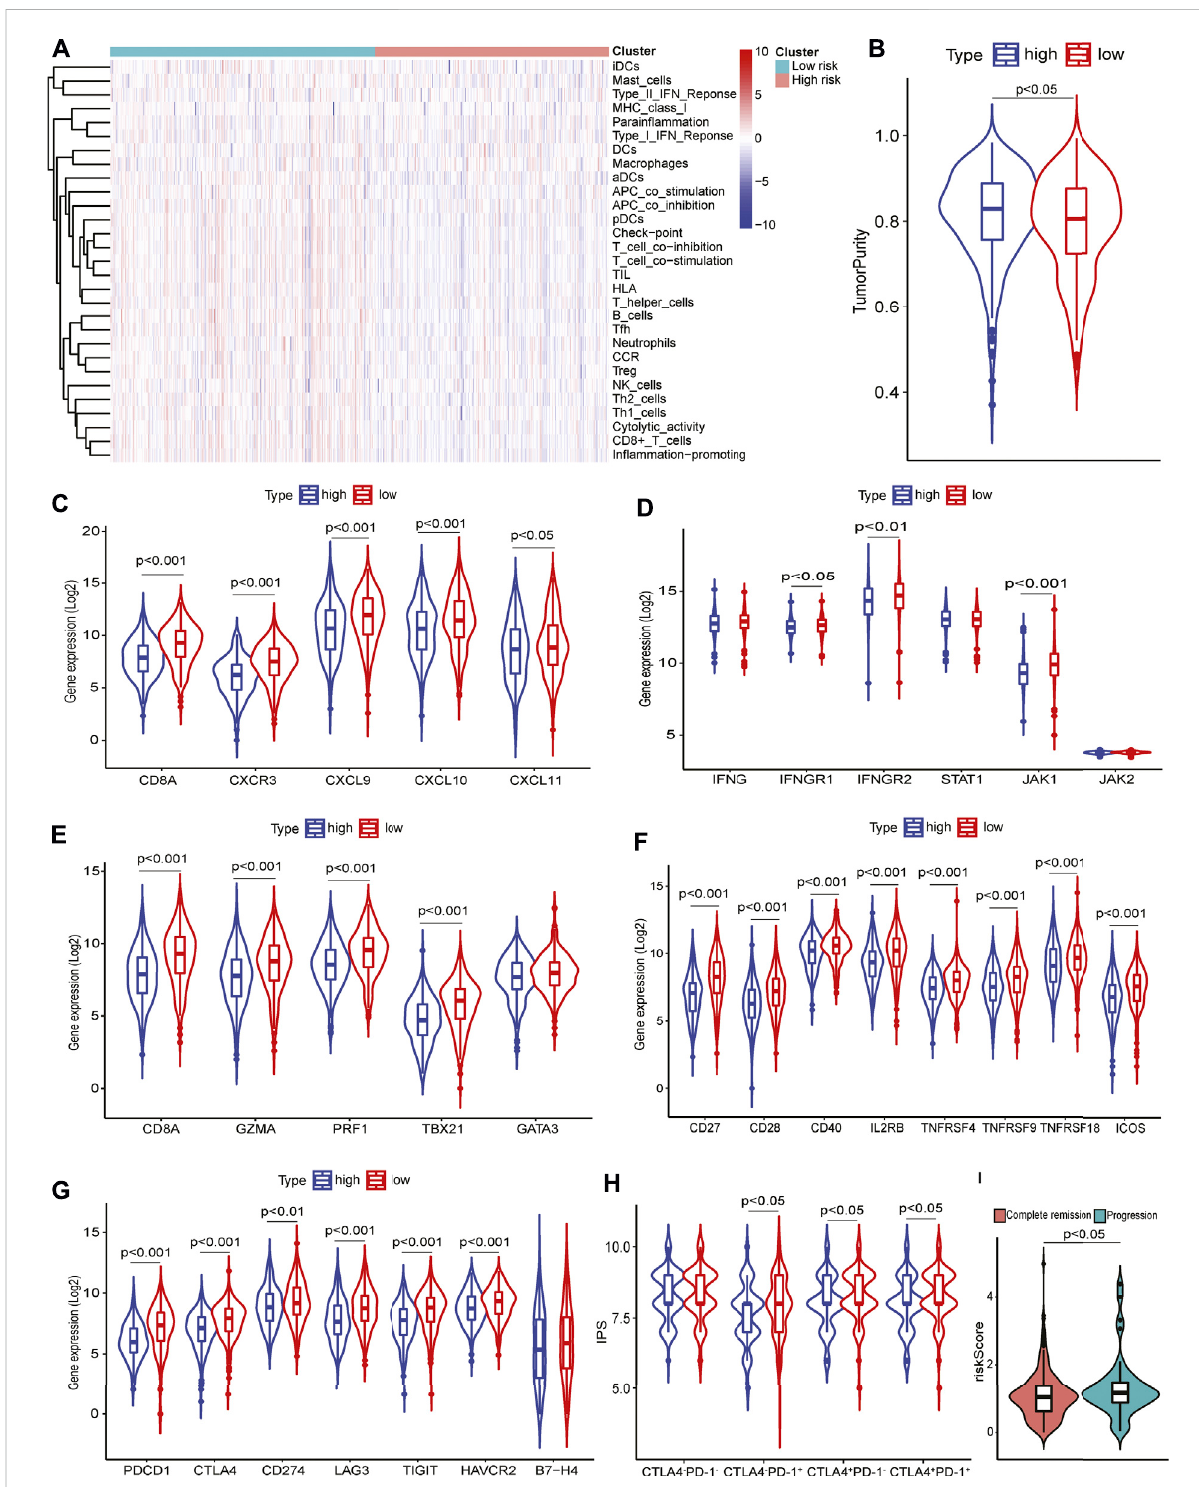
FIGURE 5 Tumor immune microenvironment analysis using 29 immune signatures through ssGSEA. (A) The immune signatures between high- and low- risk groups. (B) Tumor purity in high-and low-risk groups. (C) T cell response signatures expression in high- and low-risk groups. (D) T helper/IFN γ signatures expression in high- and low-risk groups. (E) Cytotoxic signatures expression in high- and low-risk groups. (F) Co-stimulatory signatures expression inhigh-andlow-riskgroups. (G) Co-inhibitory signaturesexpressioninhigh-andlow-riskgroups. (H) Immunophenoscore levelsin high- and low-risk groups. (I) Risk scores in patients with complete remission or progressive